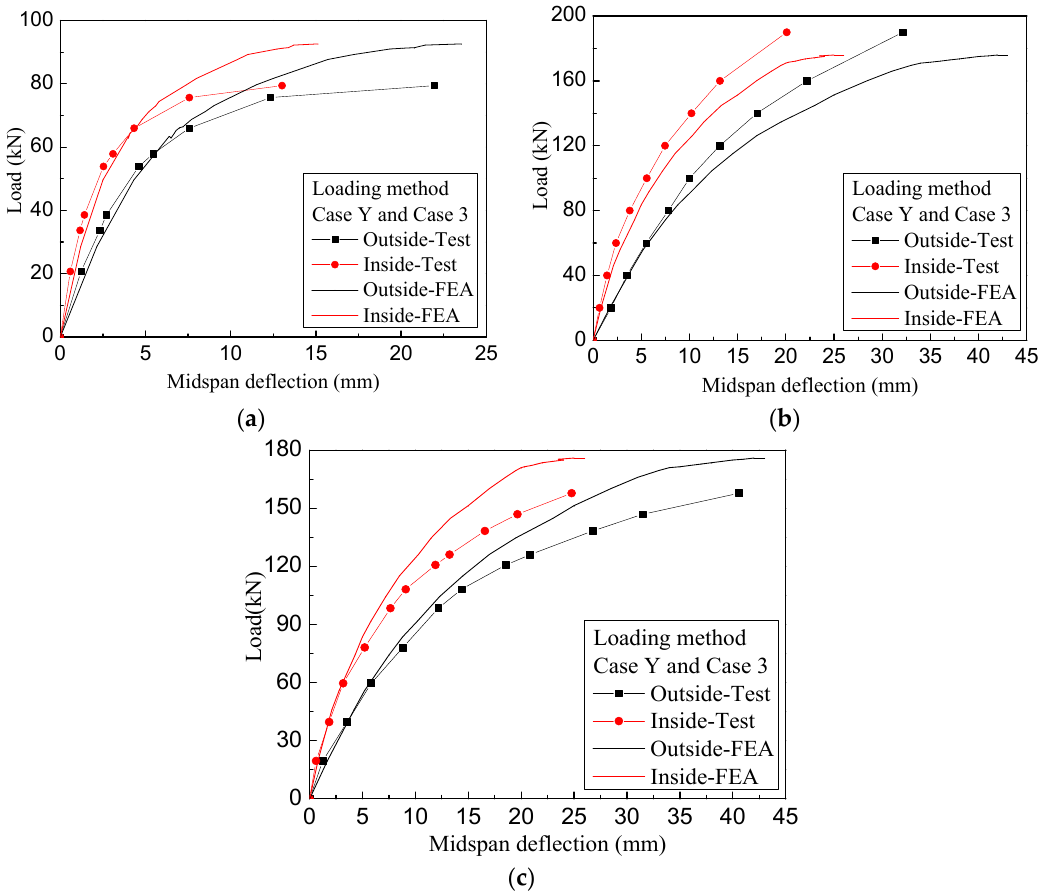
Figure 17. Load-deflection curves of test girders at mid-span section: ( a ) S1-t1d2; ( b ) S2-t2d2; ( c ) S3-t2d3.